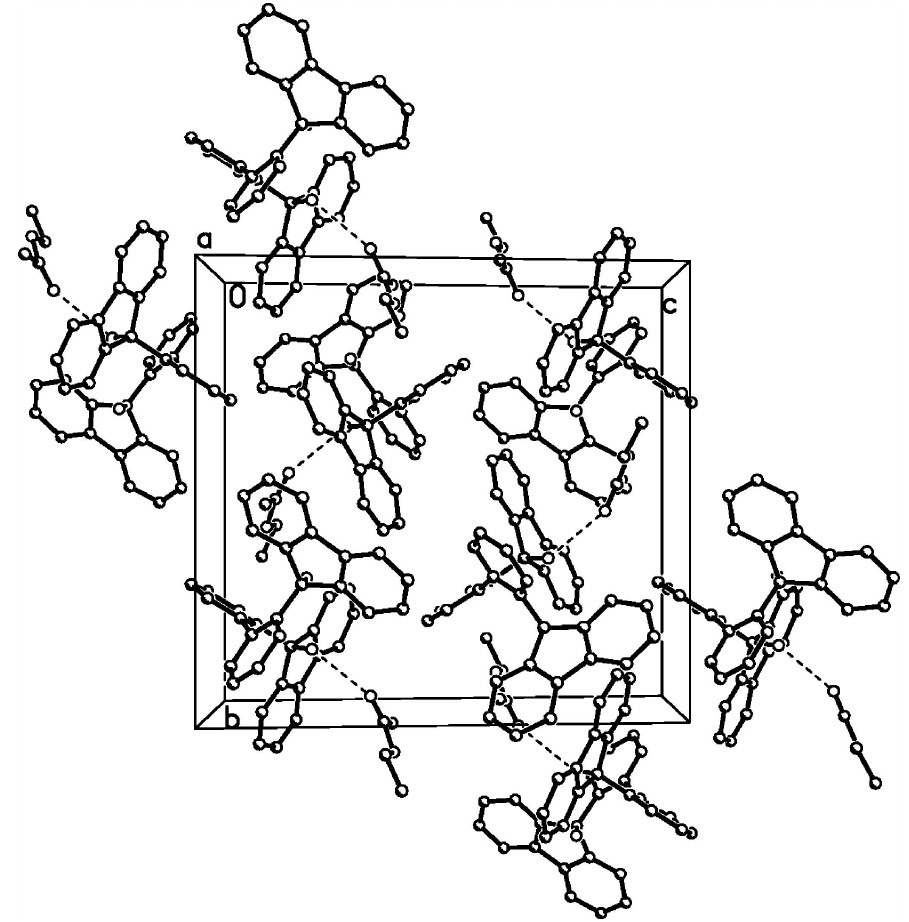
Figure 2 Packing diagram of the title compound (I) viewed down the a axis. H atoms have been ommited for clarity. Hydrogen bonds are shown as dashed